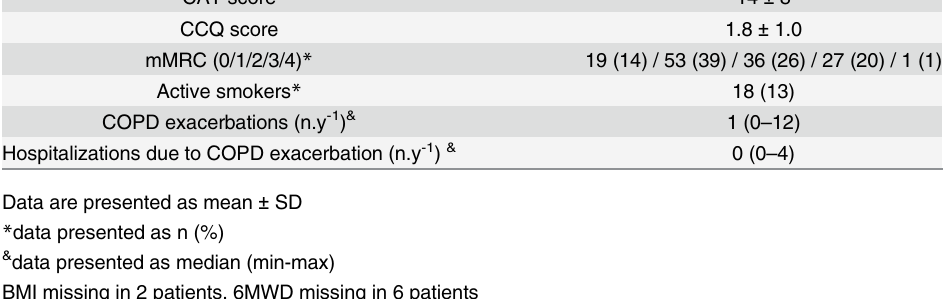
and Table B in S1 File. The different quadrants nor GOLD stages did differ in age, gender,